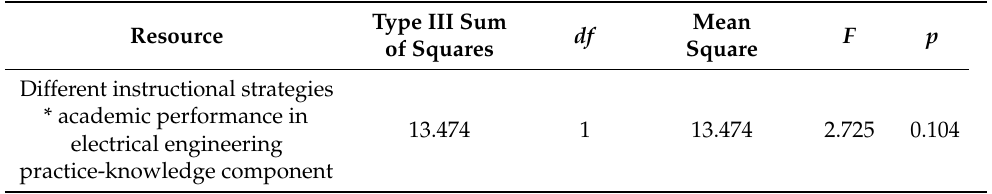
Table 12. Homogeneity of regression coefficients within groups in overall learning effectiveness- knowledge